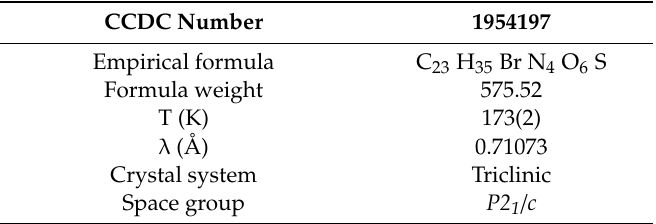
Table 1. Crystal data and structure refinement details for